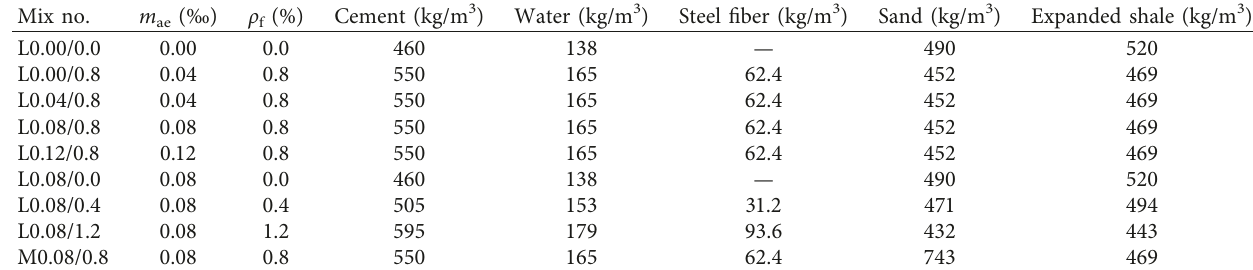
Table 2: Mix proportion of